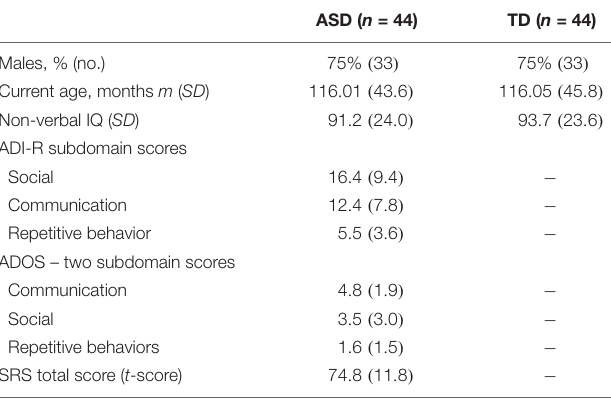
TABLE 1 | Clinical and demographic characteristics of probands with ASD and their controls enrolled in the study for alpha waves analysis in patients and TD